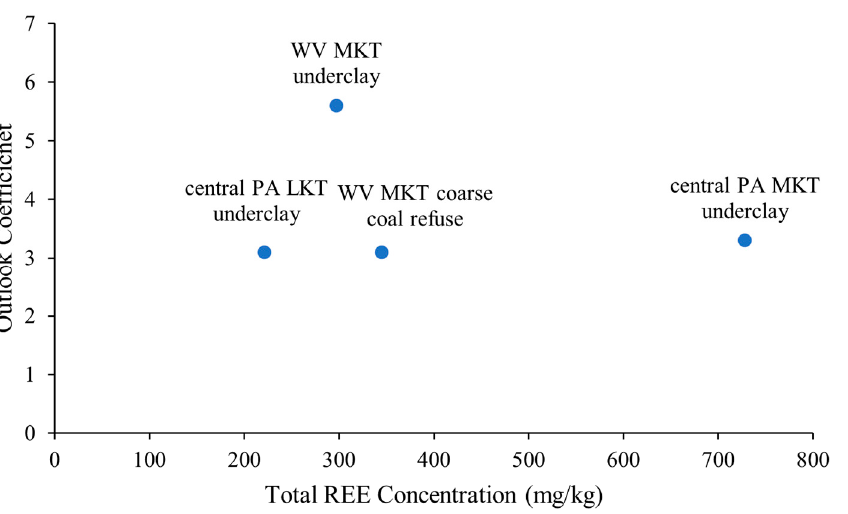
Figure 8. Outlook coefficient of each coal related sample plotted against the total REE concentration of each of each sample.